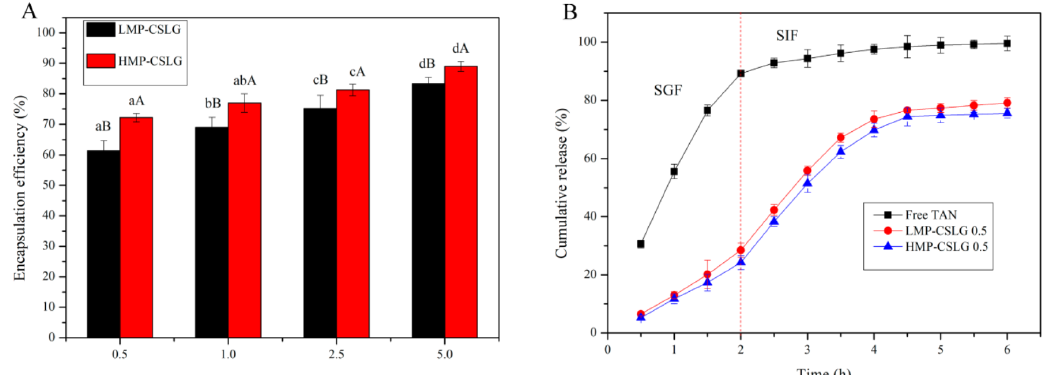
Figure 6. ( A ) Encapsulation efficiency of TAN in CSLG-based nanocomplex particles with different CSLG concentration (0.5, 1.0, 2.5, and 5 mg/mL), and ( B ) TAN release from the LMP-CSLG and HMP-CSLG nanocomplex particles with a CSLG concentration of 0.5 mg/mL under simulated gastrointestinal fluids. Low methoxyl pectin (LMP); Cationic short linear glucan (CSLG); high methoxyl pectin (HMP); Tangeretin (TAN). a–d Values followed by different letters in the same column are significantly different ( p < 0.05), where a is the lowest value. A,B Values followed by different letters in the Scheme 0. where A is the highest